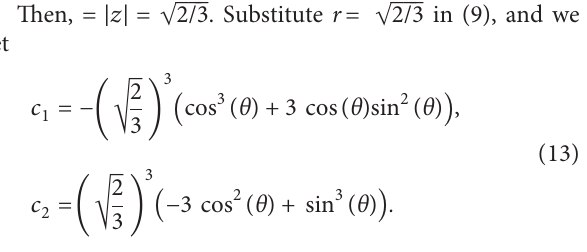
Figure 7: The general Mandelbrot set P � √ ( 0 , 1/ ) . 3